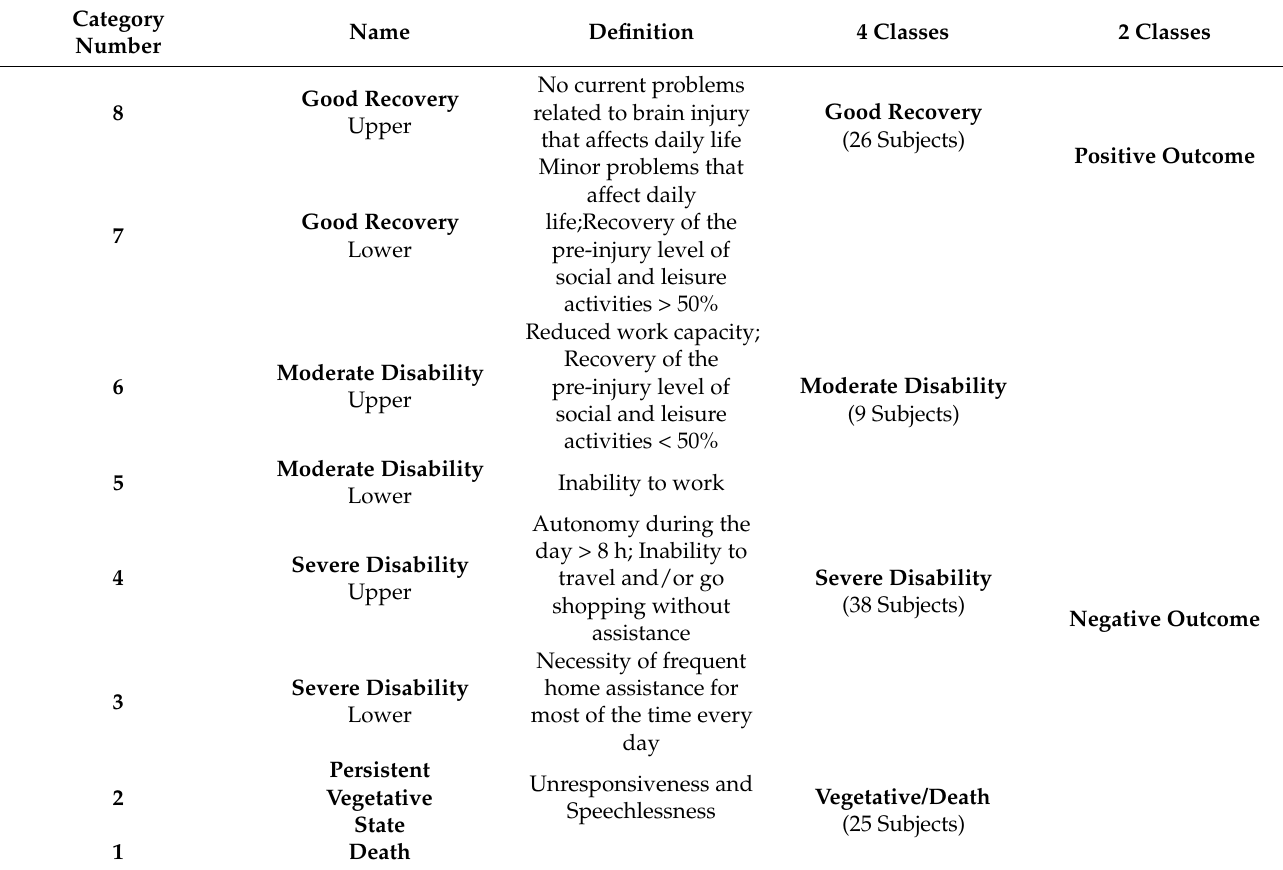
Table 2. Glasgow Outcome Scale